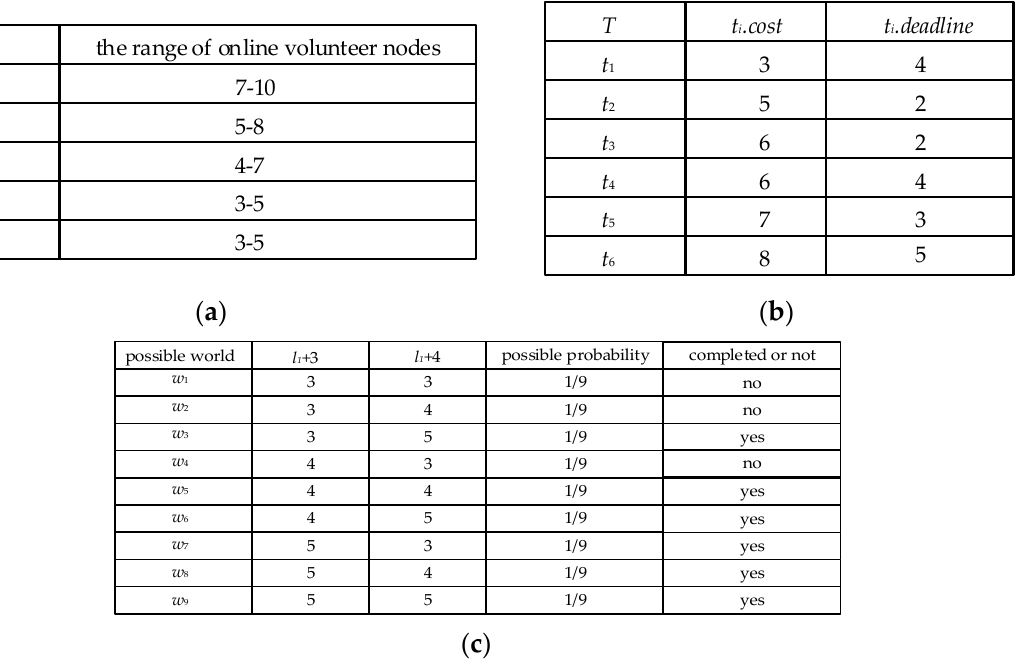
Figure5. Anexampleofusingariskpredictionmodeltopredictcompletionriskofthetask. ( a )Therange Figure 5. An example of using a risk prediction model to predict completion risk of the task. (a) The of online volunteer nodes from time l 1 to time l 1 + 4; ( b ) list of tasks at time l 1 ; ( c ) the possible world set range of online volunteer nodes from time l 1 to time l 1 + 4; (b) list of tasks at time l 1 ; (c) the possible W of the task t 6 world set W of the task t 6 .